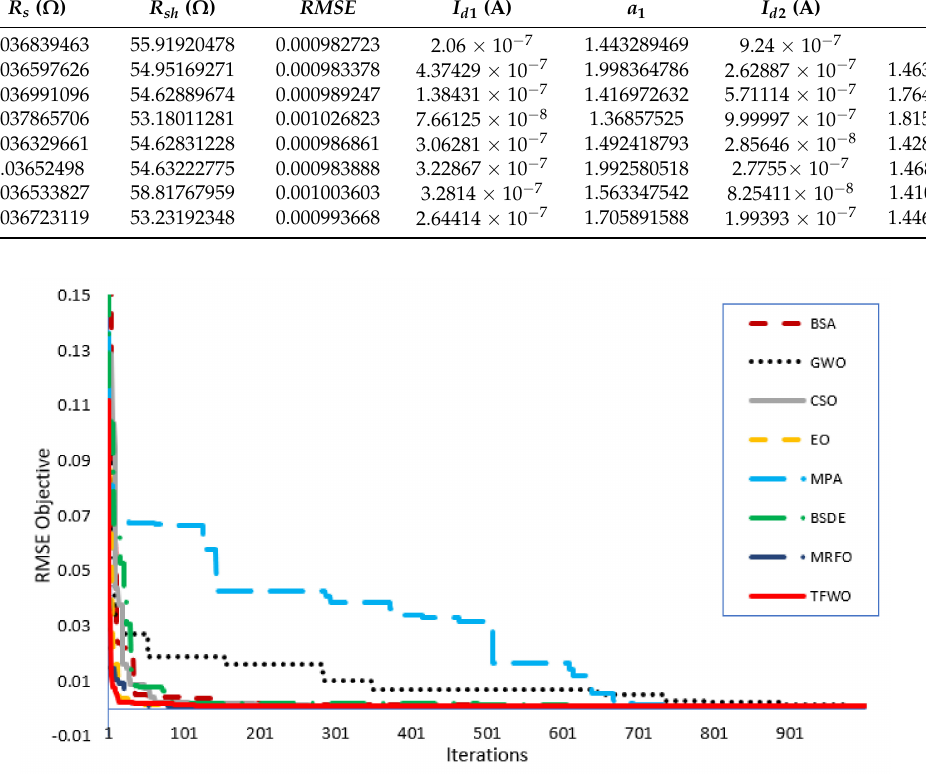
Figure 9. The convergence curves for R.T.C. France